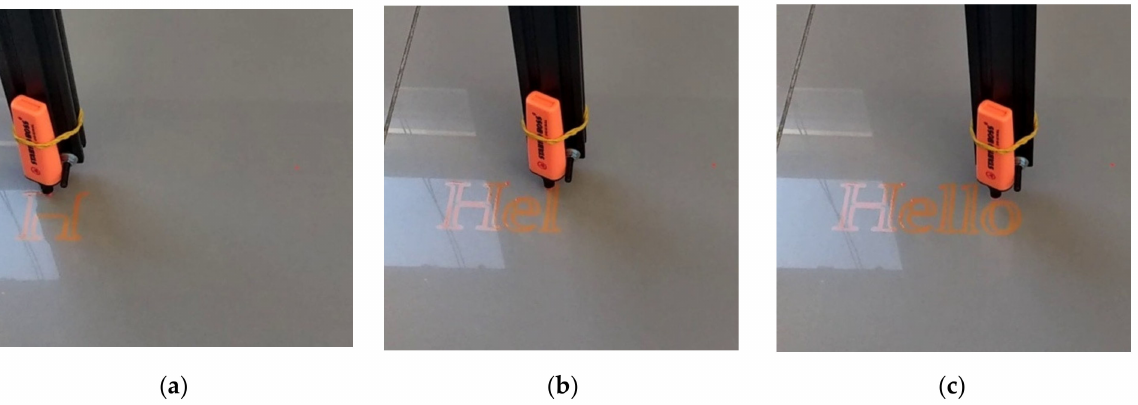
Figure 22. CityVeg second movement test, “Hello”. ( a ) Step 1/3, ( b ) Step 2/3, ( c ) Step 3/3. Judging by the final result, CityVeg was capable of depicting an extremely realistic floor drawing of the provided script. This visual validation indicates that there are no sig- nificant deviations from the targets that CityVeg is asked to approach. Both test results are considered sufficient for the performed application of irrigation, as this level of inaccuracies does not affect the performance of CityVeg in real world